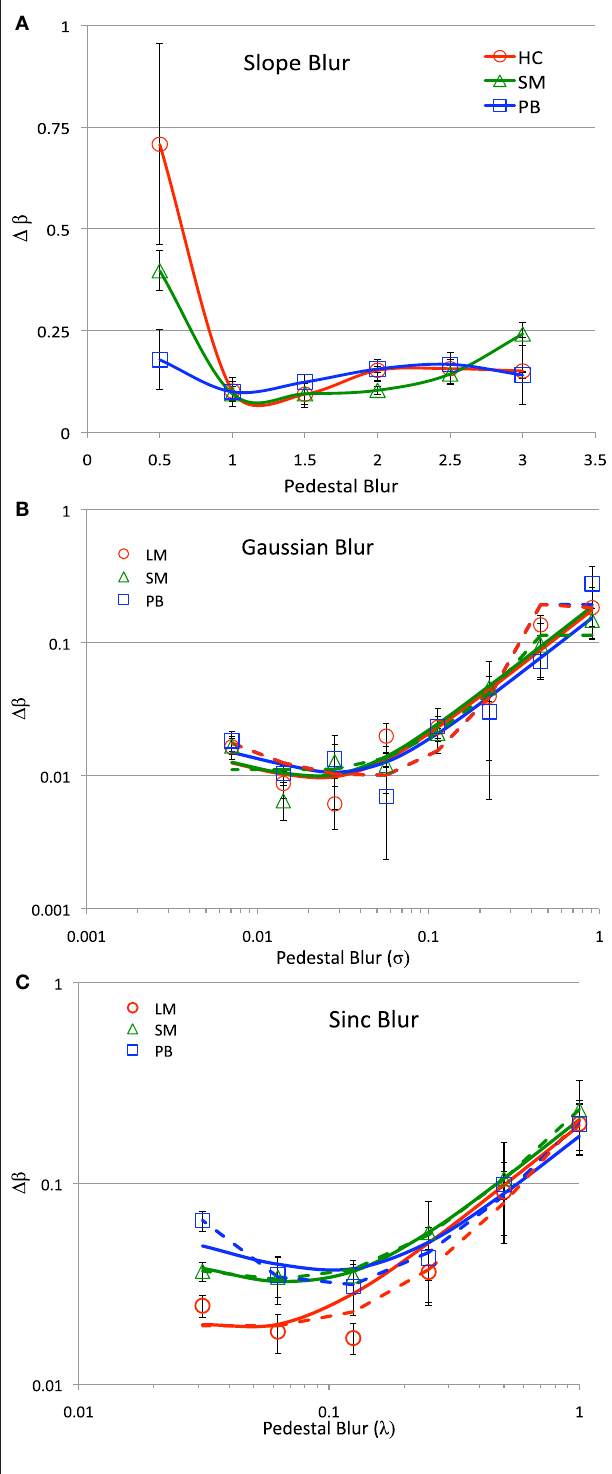
Figure 2 | Blur discrimination thresholds for three observers, indicated in the legend and for three classes of blur (A) Amplitude Spectral Slope; (B) Gaussian, and (C) Sinc. The abscissa shows the level of blur present in the standard image, the ordinate show the change in blur required for detection of the more blurred image on 75% trials. Error bars show ± 95% confidence